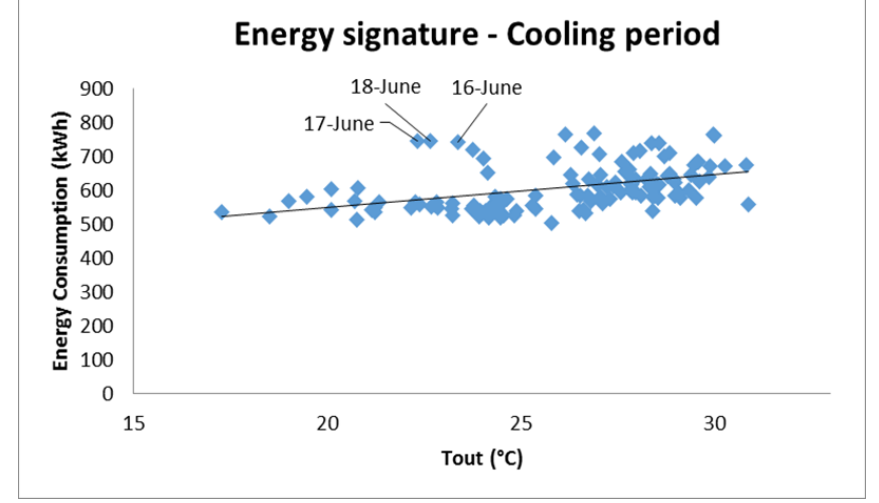
Figure 10. Energy signature of the Β FEPA building for the cooling period (April – October 2018).